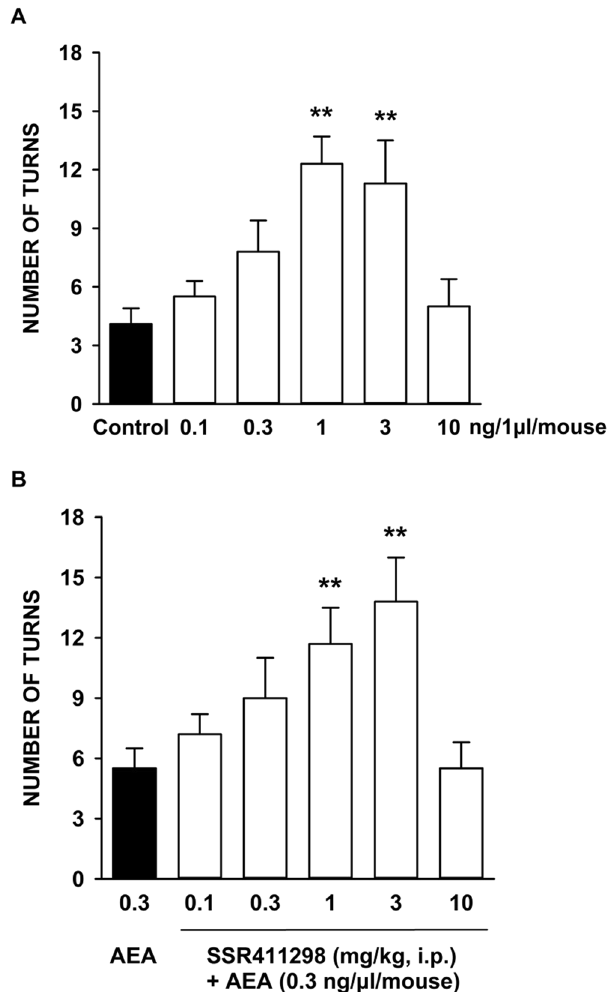
Figure 4. Potentiation by SSR411298 of turning behavior induced by intra-striatal infusion of anandamide (AEA) in mice. ( A ) Dose-response of AEA; ( B ) Potentiation by SSR411298 of the effects of AEA. Data represent the mean ± SEM. ** P < 0.01 (Dunnett's t-test) vs. control or AEA-treated group. N = 12 to 24 mice per group.